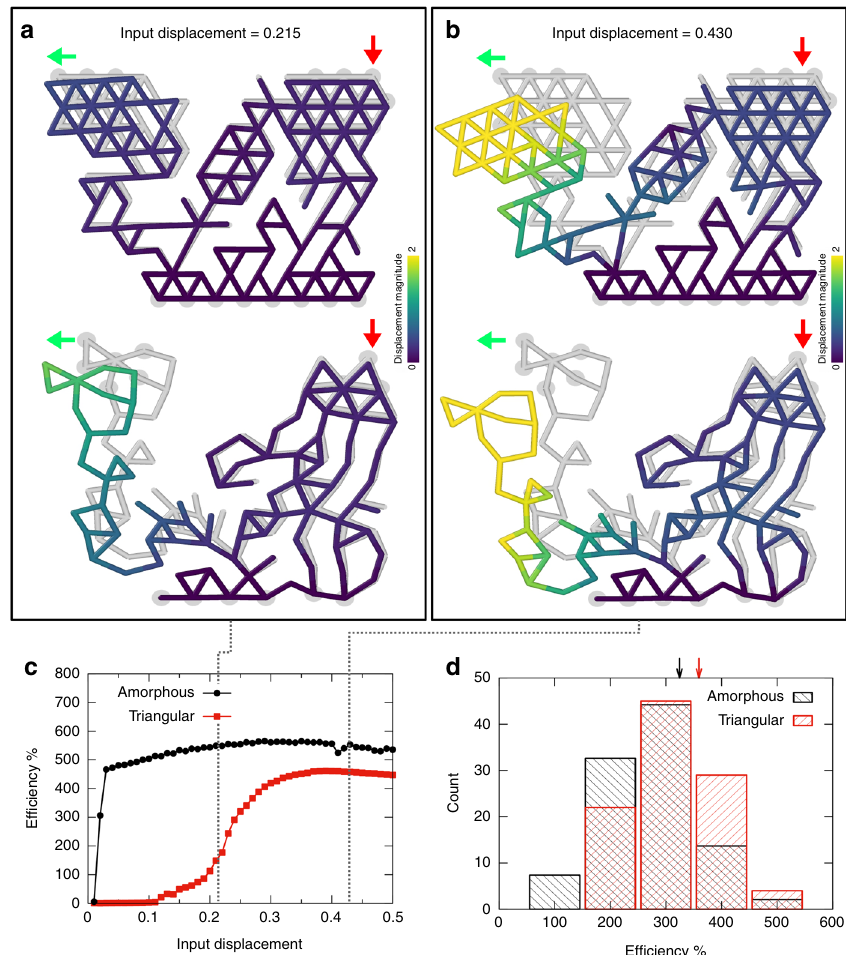
Fig. 4 Lattice geometry and buckling effects. a example of actuators with orthogonal input – output movement, obtained starting from a triangular (top) and amorphous (bottom) lattices. b The same as ( a ) but with a larger displacement of input nodes. Red (green) arrows indicate the direction of the desired input t inp (output t out ). c Ef fi ciency as a function of the input displacement for the same two actuators in (a),(b). Error bars are standard deviations. d Ef fi ciency distribution for 100 generated actuators using triangular or amorphous lattices. Arrows report the average ef fi ciency for the two